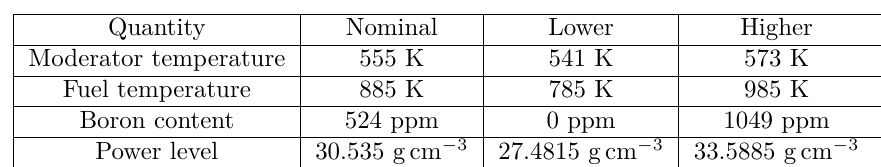
Table 3. Operational uncertainties